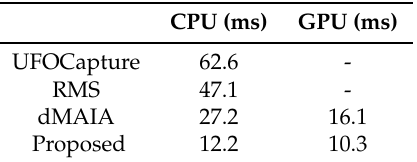
Table 1. Time for processing a single frame.